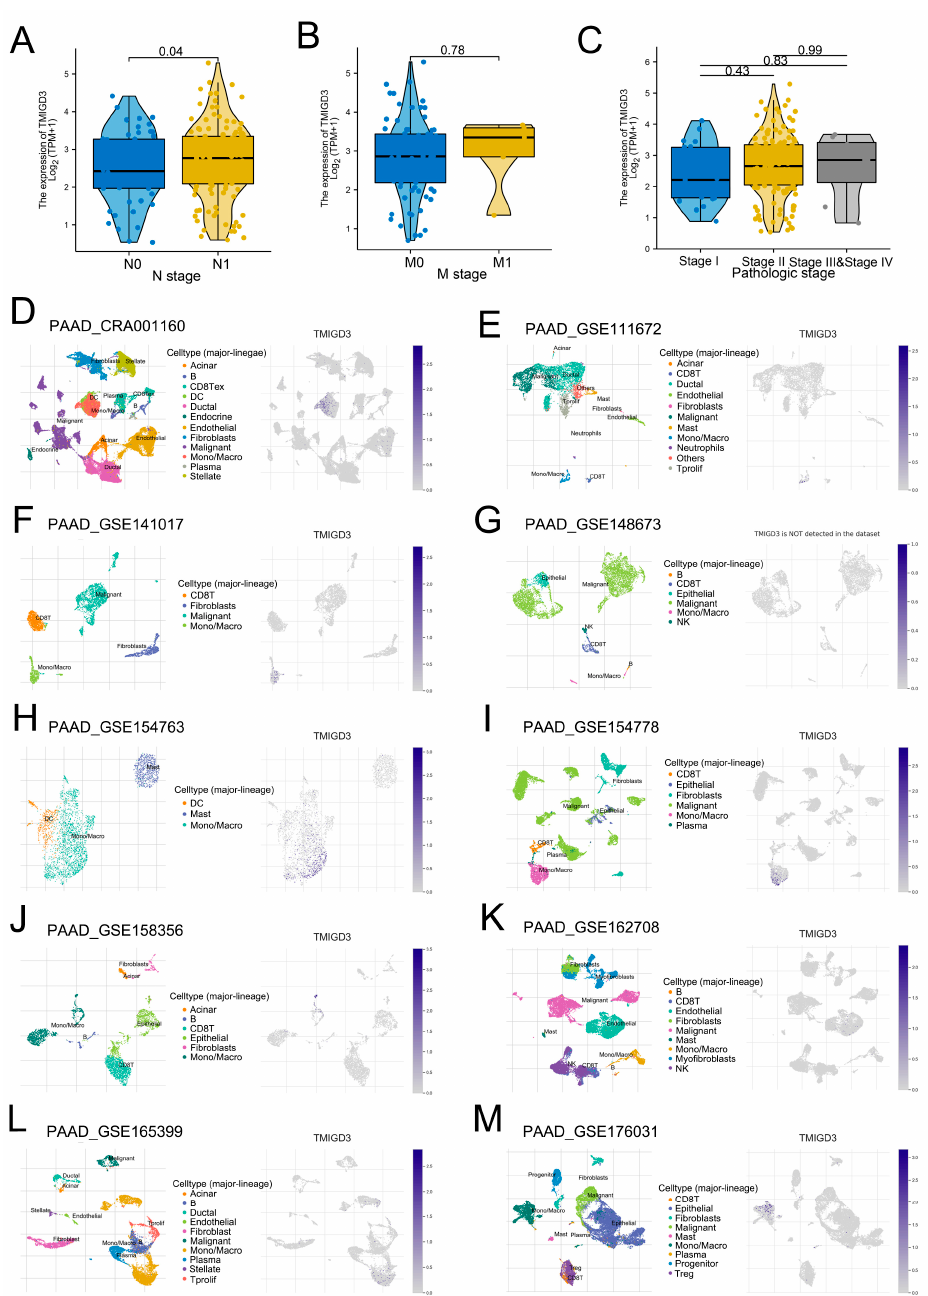
Figure 4. Expression pattern of TMIGD3 in PC. Notes: ( A – C ) Expression level of TMIGD3 in patients with different clinical features; ( D – M ) The single-cell gene of TMIGD3 in PC.